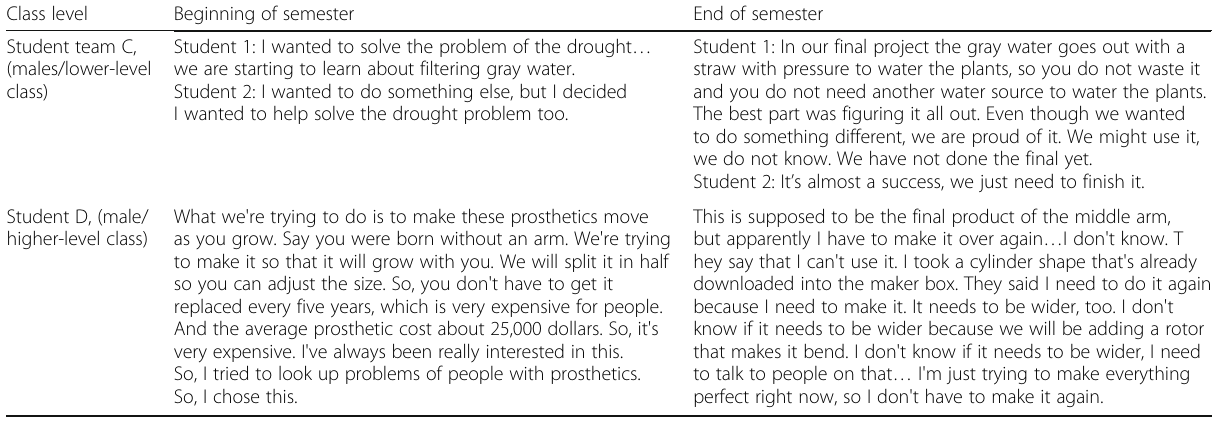
Table 7 Exemplary student quotes demonstrating situational interest